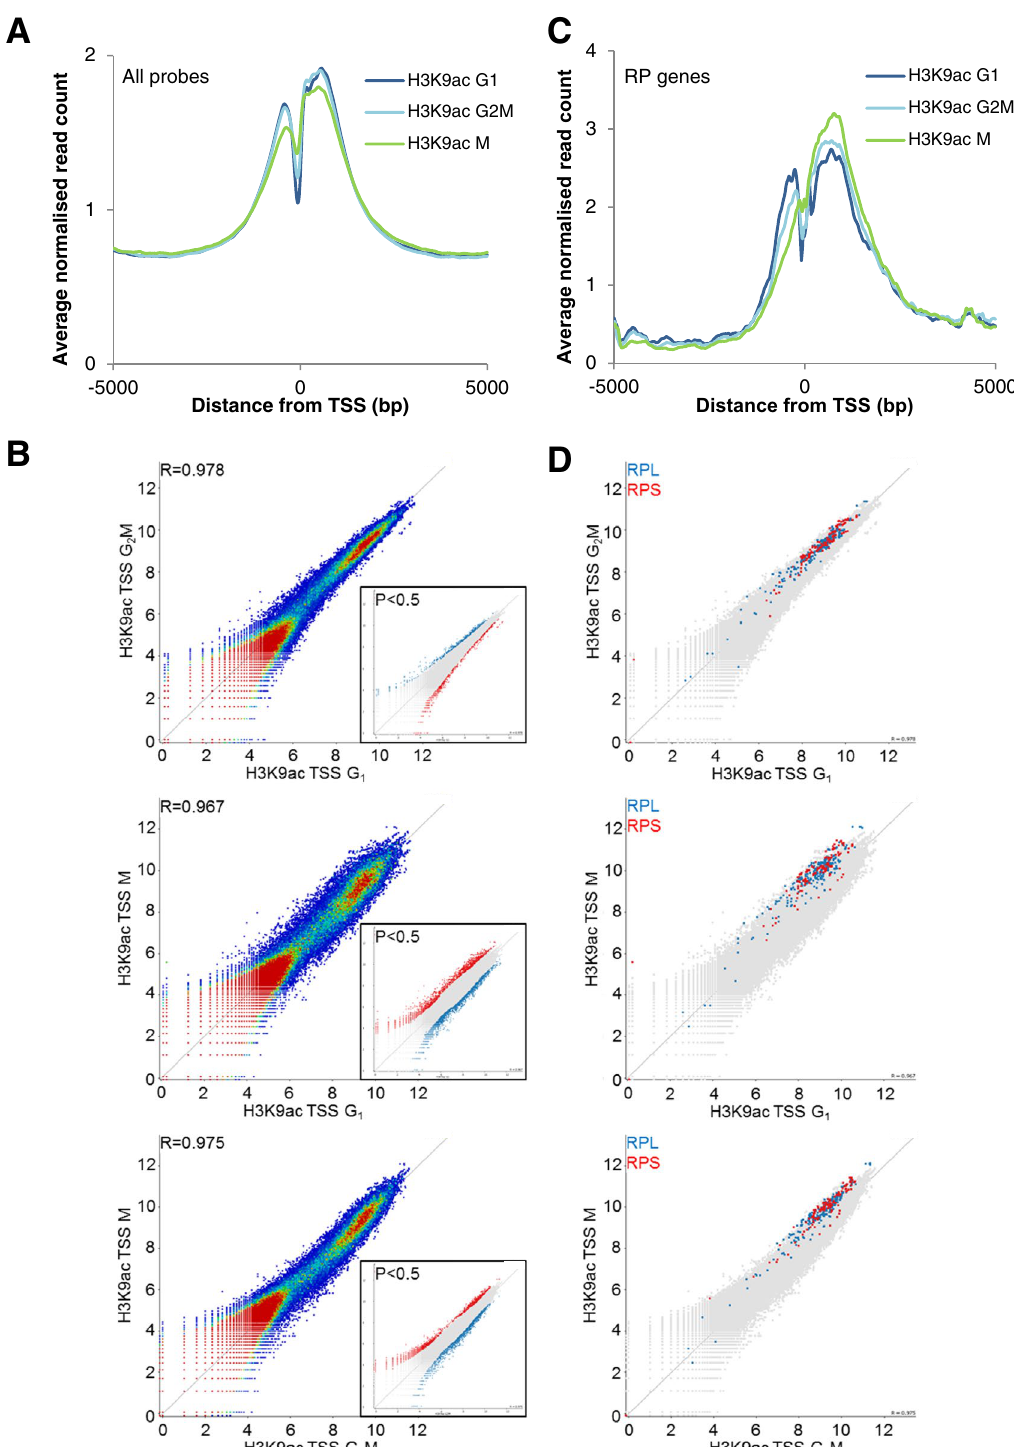
Figure 7. Transcription start sites of ribosomal protein genes are enriched in H3K9ac in mitosis in HeLa cells. ( A ) HeLa cells were sorted by centrifugal elutriation (G 1 , G 2 M) and mitotic shakeoff (M). Average distribution (average read count normalised to total read count) across a 10 kb window centred on all transcription start sites (TSS) is shown. ( B ) ChIP-seq signal at TSS (− 500 bp to + 750 bp) is compared between cell cycle phases. Significantly enriched TSS (P < 0.5) were identified by intensity difference as shown in the inset panels. ( C ) The average H3K9ac distribution across the TSS of ribosomal protein (RP) genes (large and small, excluding mitochondrial) is shown. ( D ) ChIP-seq signal at TSS of ribosomal protein genes is compared between cell cycle phases. RPL genes are shown in blue and RPS genes in